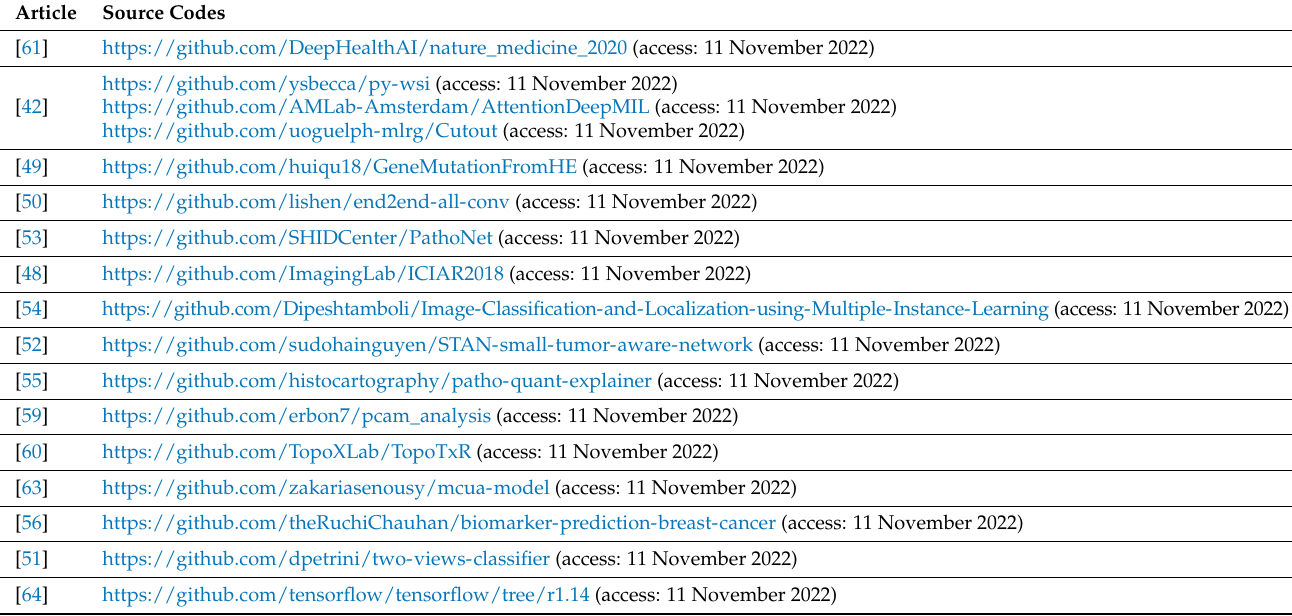
Table 3. Articles that have open-source